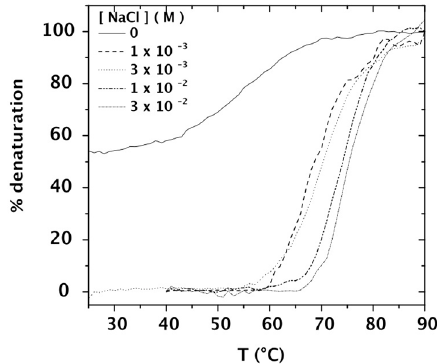
Figure 2. Temperature dependence of the % denaturation calculated from the absorbance at 260 nm of calf-thymus DNA 0.042 mg/mL at salt concentrations up to 3 × 10 − 2 M NaCl, taking as reference the absorbance at 25 °C.